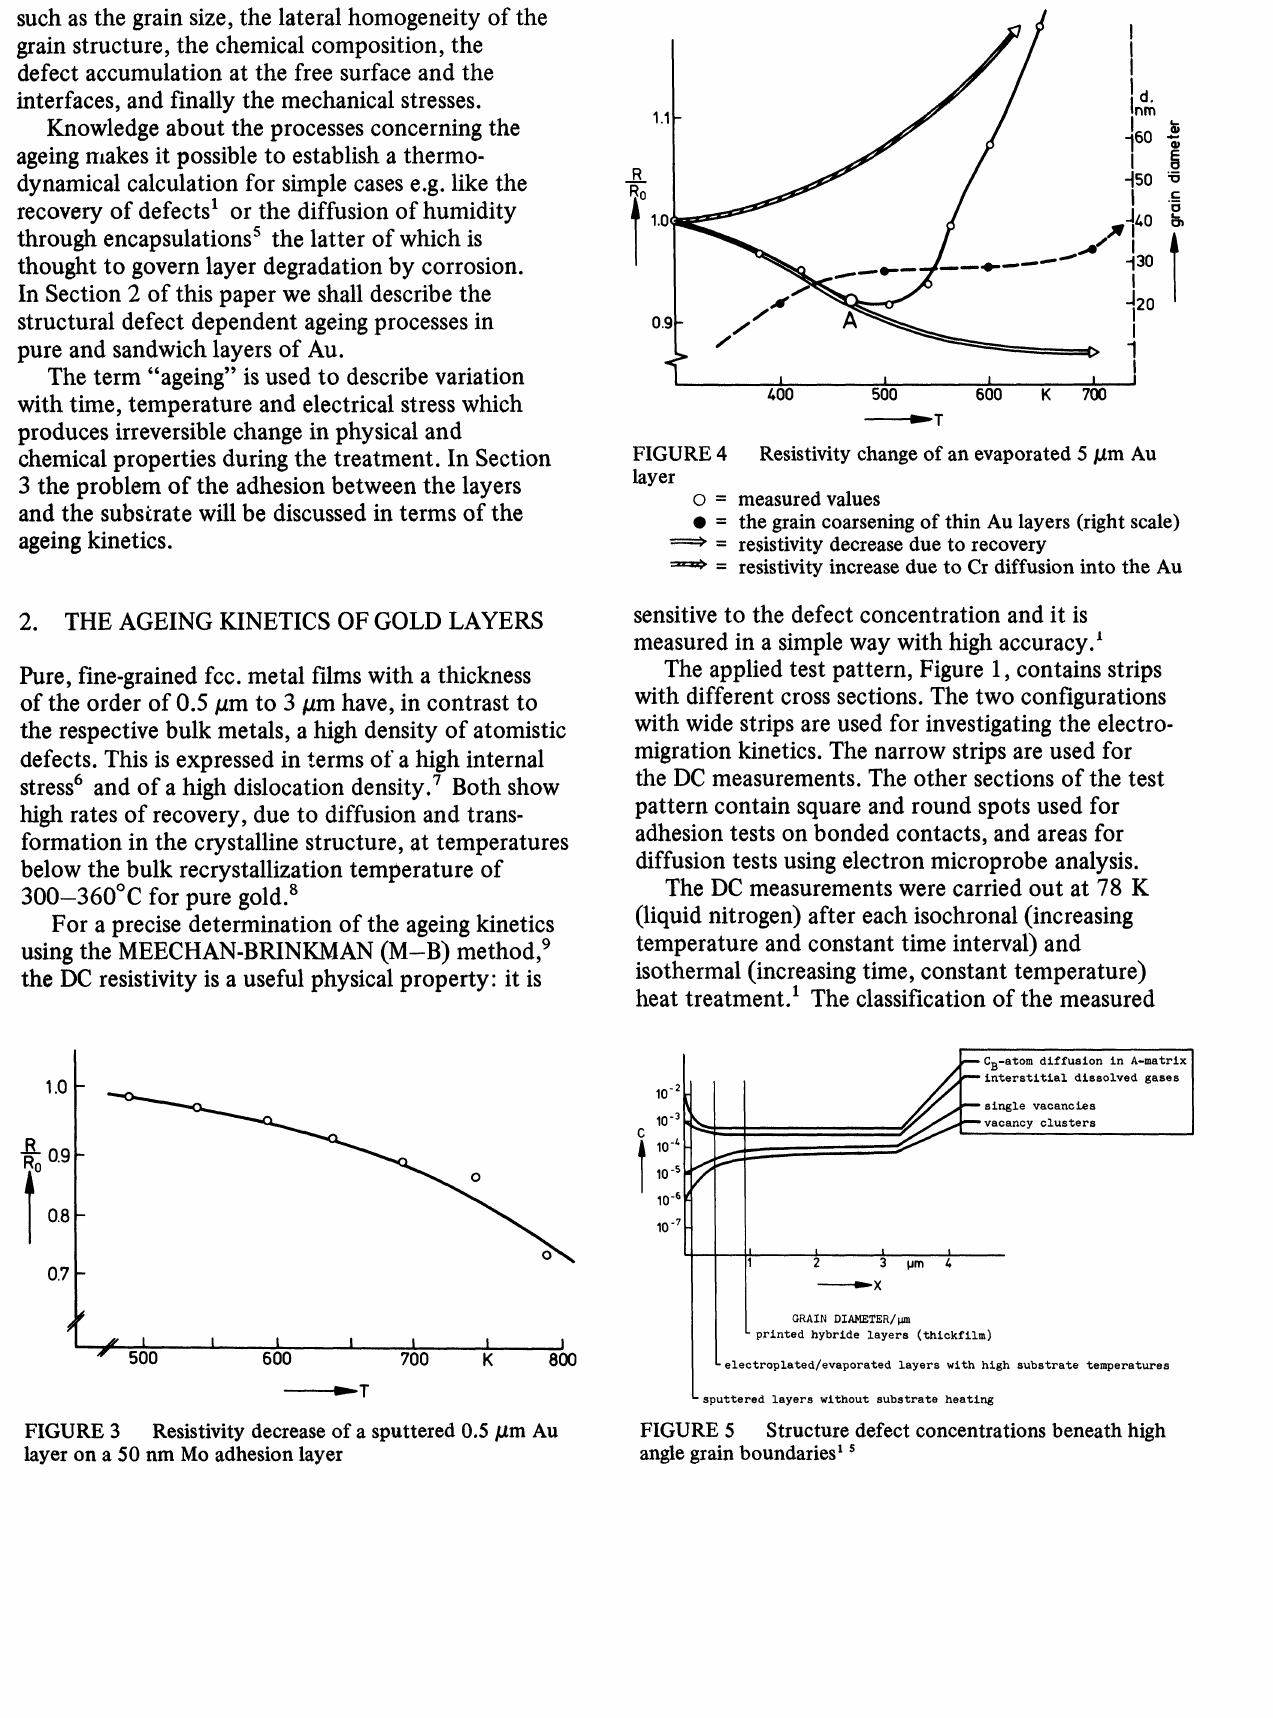
-electroplated/evaporated layers with high aubatrate temperatures sputtered layers without substrate heati Structure defect concentrations beneath high angle gain